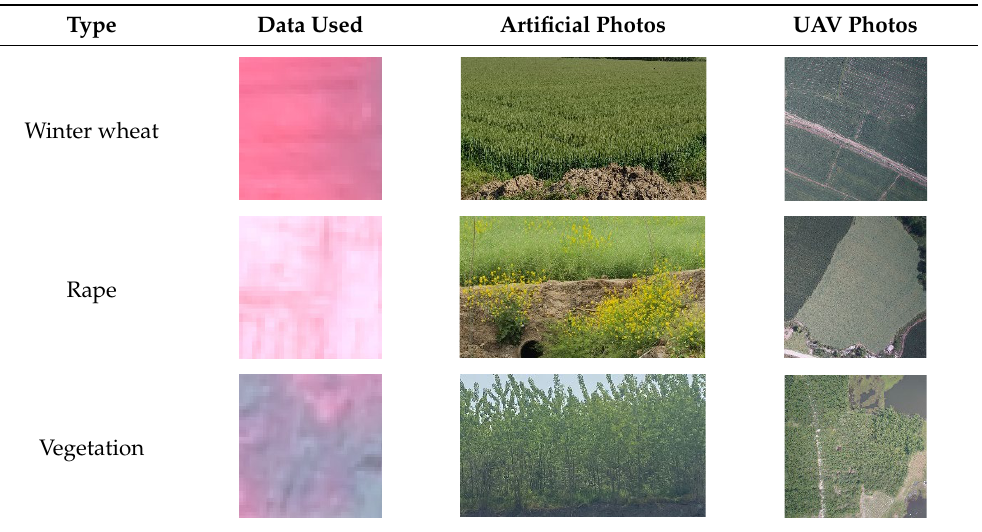
Figure 6. Field survey area on GF-2 images. Table 4. Schematic diagram of the main types in the field survey area.